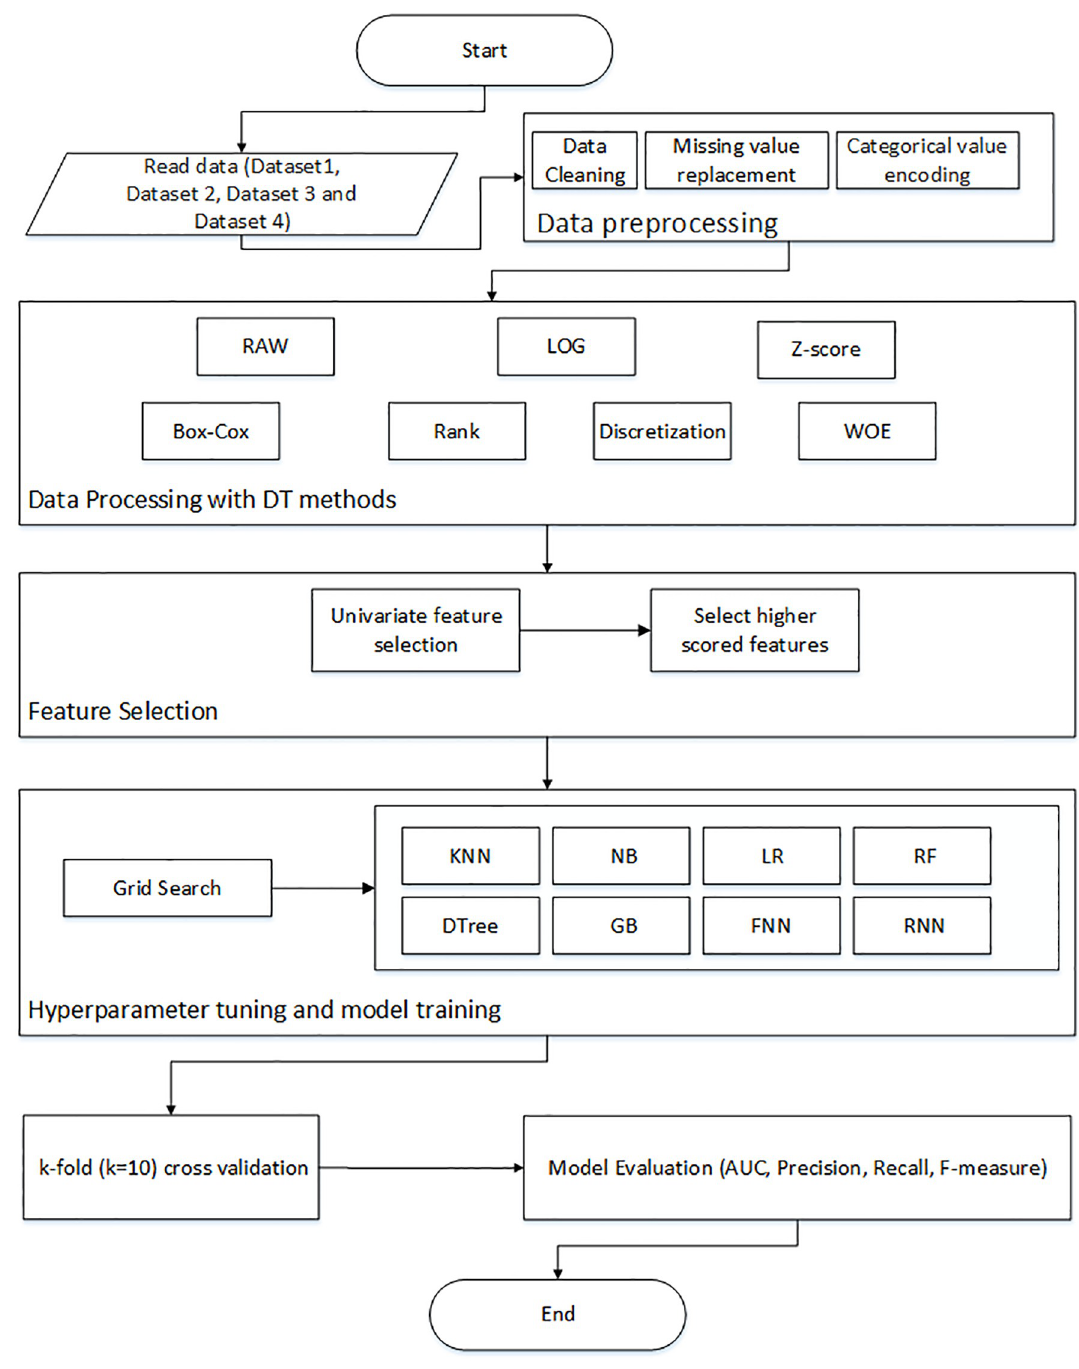
Fig 2. Flowchart of the optimized CCP model using data transformation